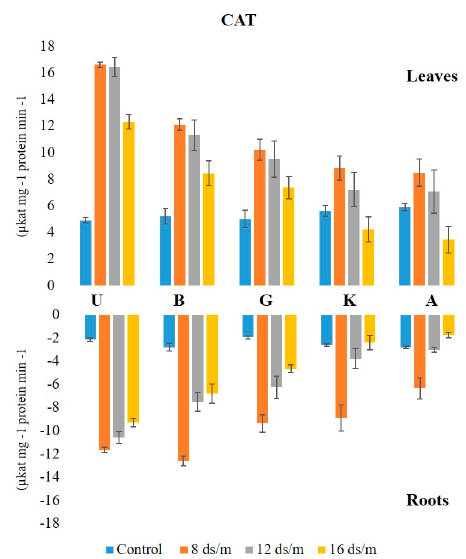
Figure 6. Effect of NaCl-mediated stress at 100 days of treatment on CAT activity in leaves and roots of pistachio.